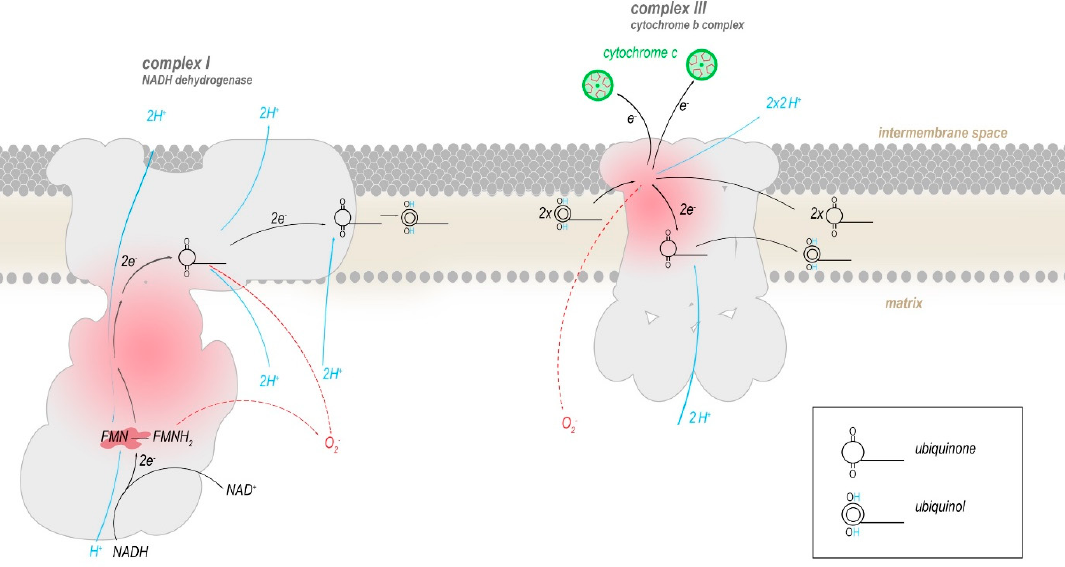
Figure 3. Complex I and III interaction with ubiquinol.